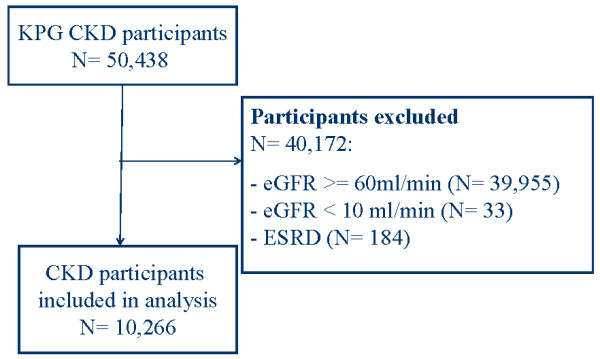
Study Flow Chart.